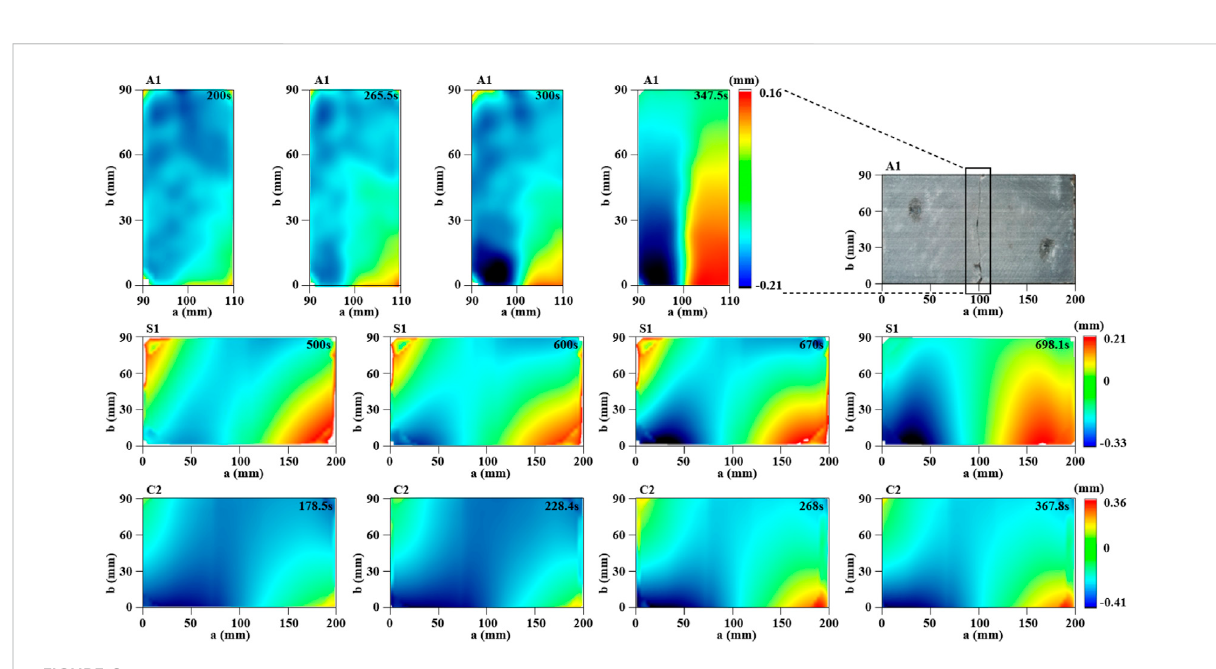
FIGURE 6 X -direction displacement cloud